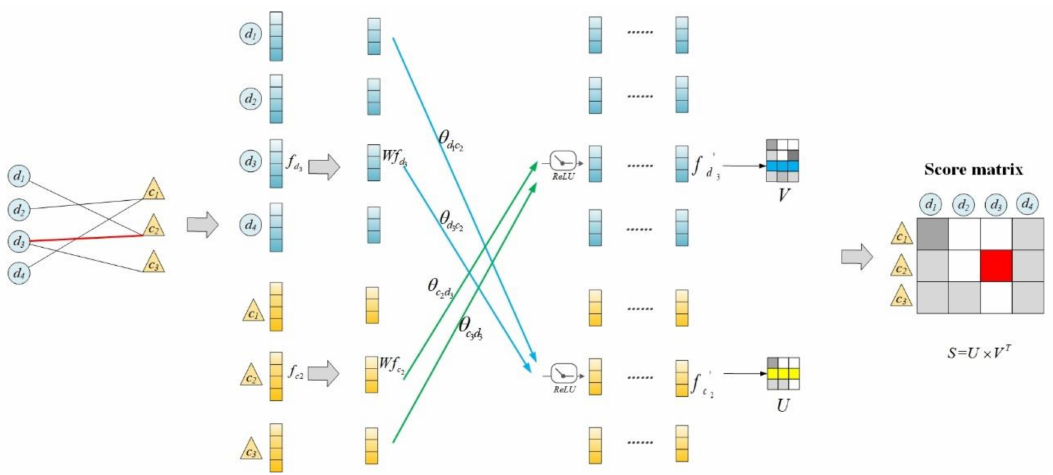
Figure 2. The detailed procedures of using GAT to predict the associations between circRNAs and